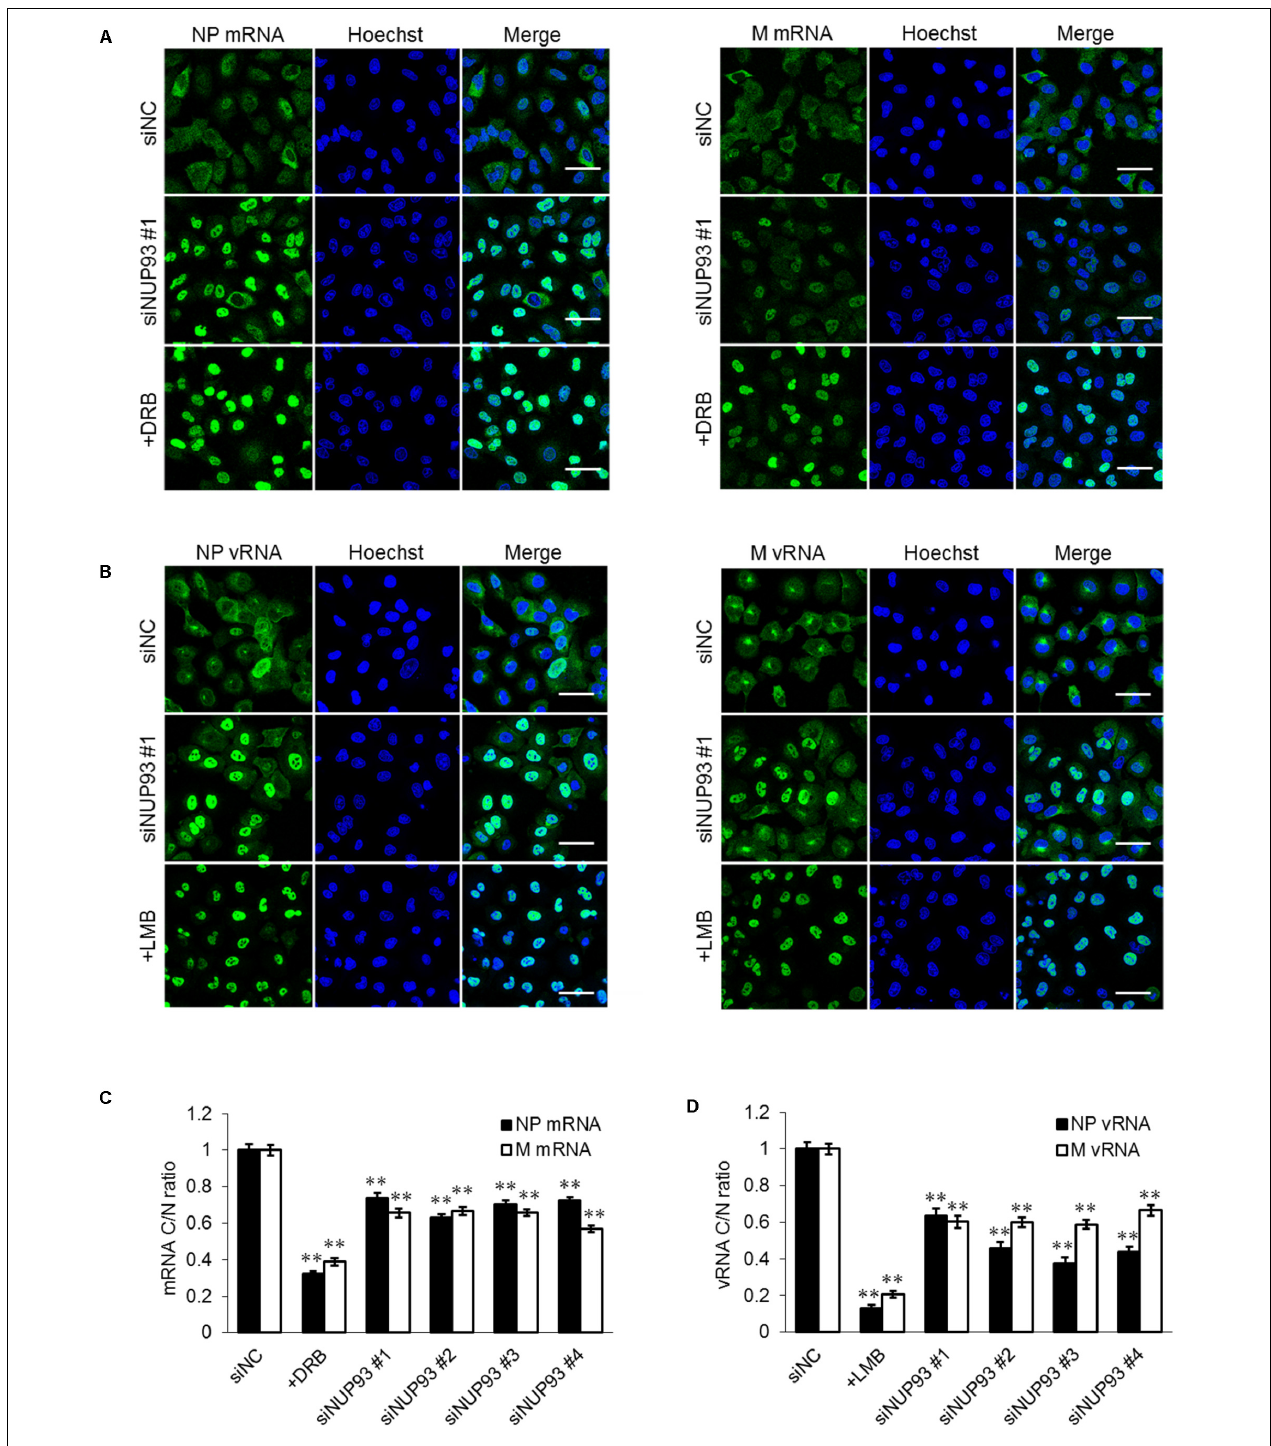
FIGURE 4 | NUP93 knockdown causes accumulation of viral RNA in the nucleus. (A,B) A549 cells transfected with siRNAs were infected with WSN virus at an MOI of 10. Cells were fixed at 8 h post-infection and (A) NP/M mRNAs or (B) NP/M vRNAs were detected by fluorescence in situ hybridization. The images were obtained using confocal microscopy. Scale bars: 50 µ m. (C,D) Cytoplasmic to nuclear ratio (C/N) of (C) mRNA and (D) vRNA at 8 h post-infection was determined in 200 cells for each condition. Values are means ± SE. ∗∗ p < 0.01 (one-way ANOVA followed by Dunnett’s test). The results are representative of at least three independent